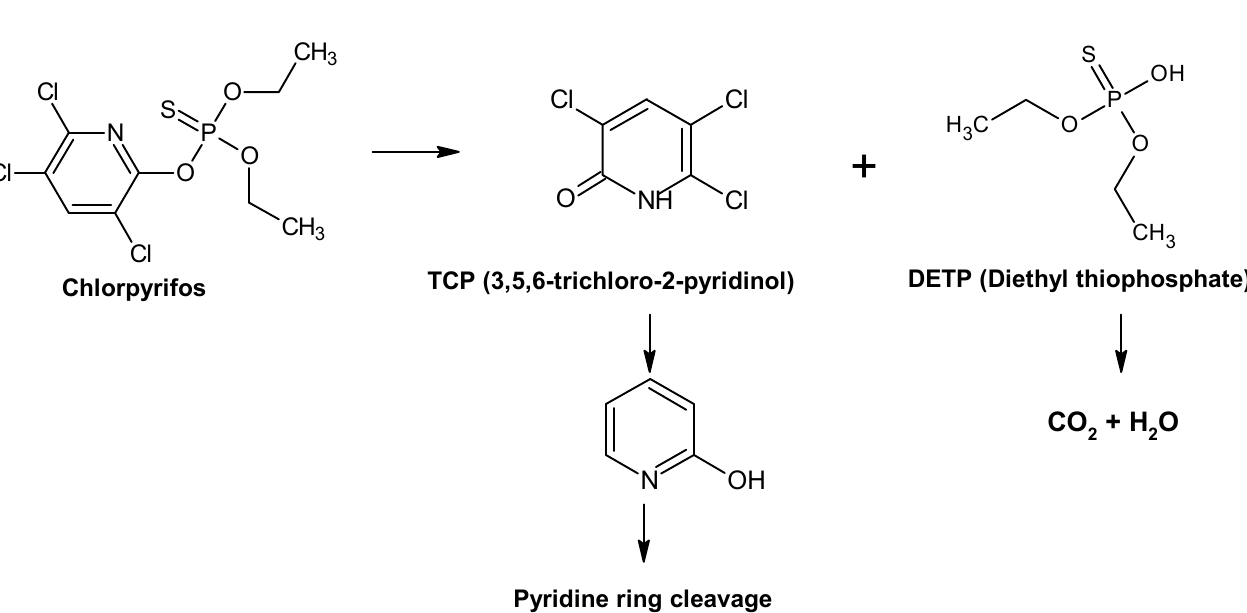
Figure 3. Proposed pathway for degradation of chlorpyrifos by Ochrobactrum sp. JAS2 [223].